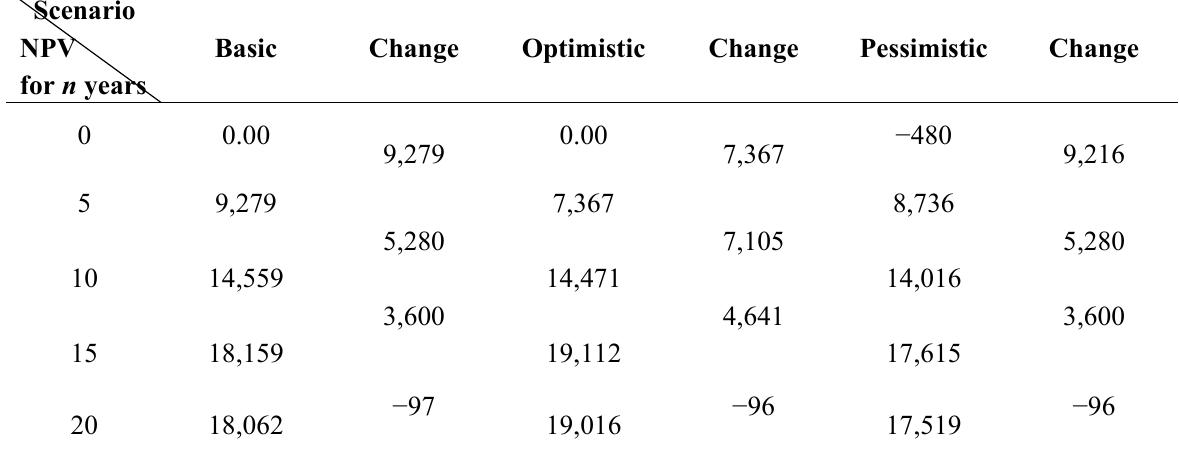
Table 5. Changes in NPVs between successive five-year periods (in EUR—during conversion from PLN to EUR numbers were